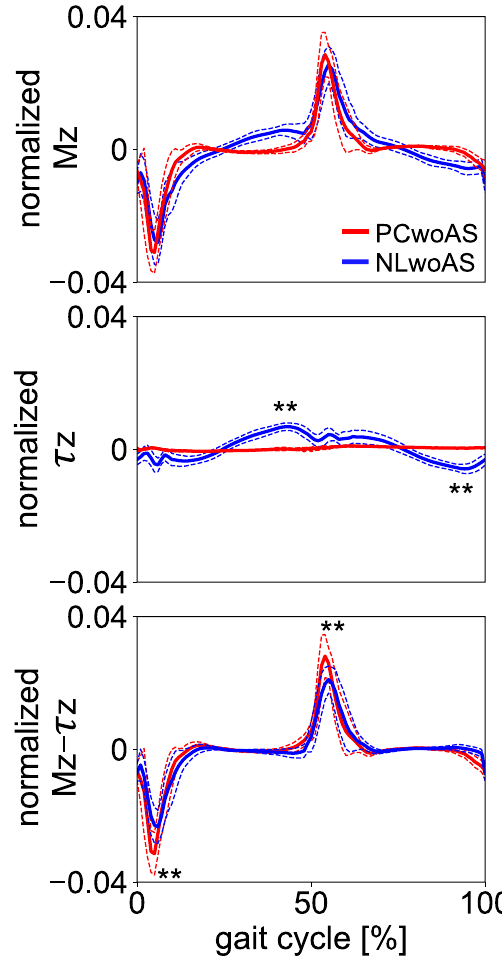
Figure 5. Mean normalised vertical external moment profiles during walking with NL and PC shoes when the arm swing was restrained (NLwoAS and PCwoAS, respectively). Normalised net moment (M z ), moment due to VFM (τ z = τ zL + τ zR ), and moment due to GRF (M z −τ z ) are presented. Corresponding dashed lines represent standard deviations. Asterisks indicate statistical differences of the maximum or minimum values between NLwoAS and PCwoAS (*: p < 0.05. **: p <